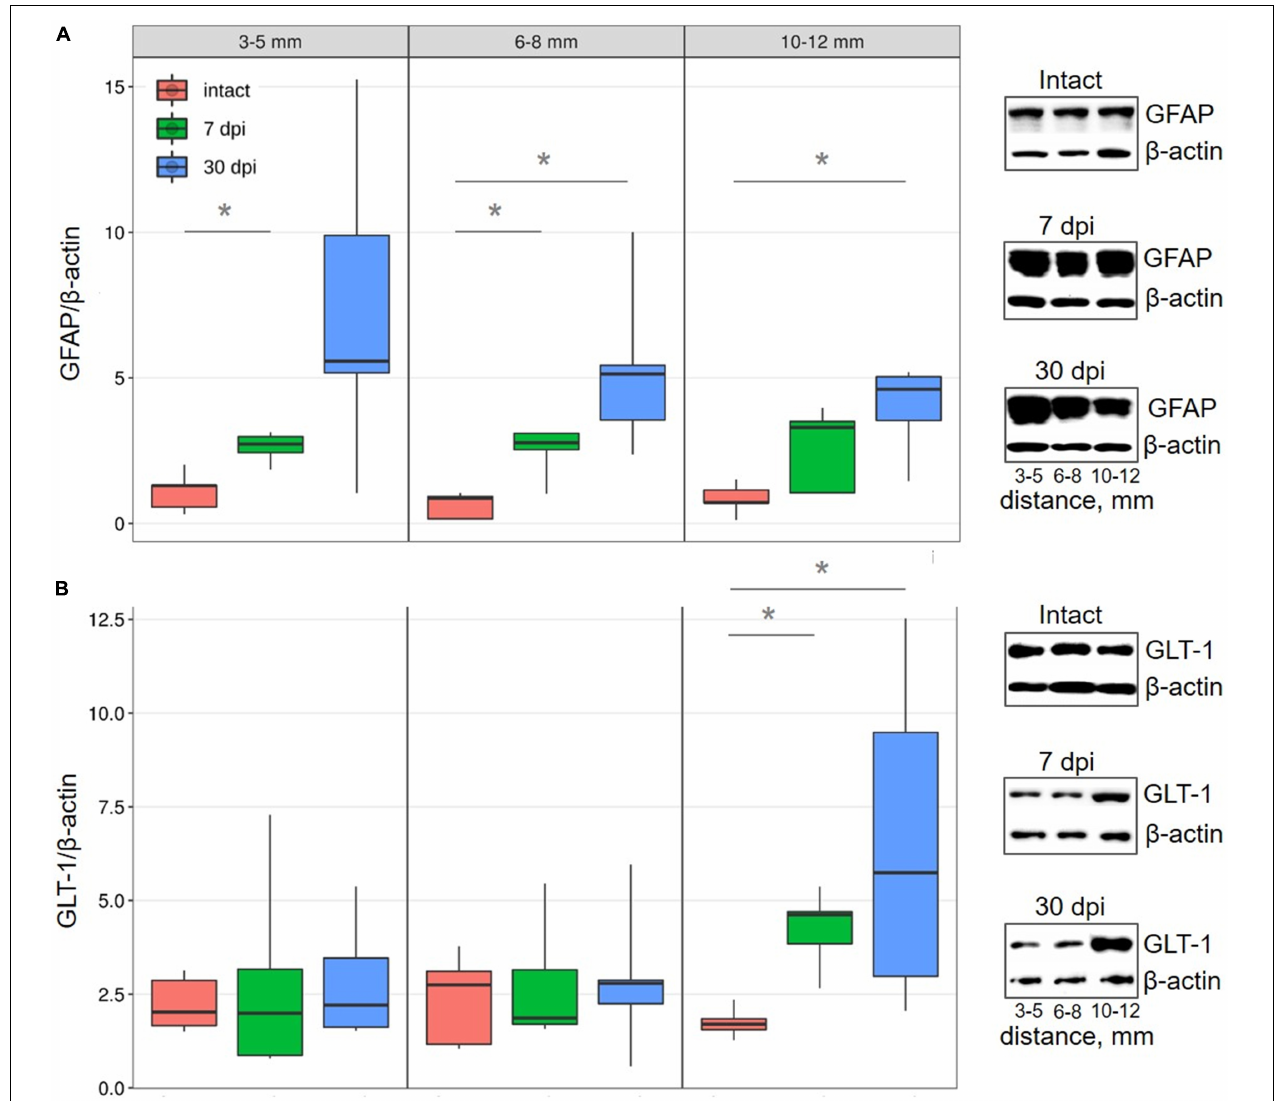
FIGURE 2 | Western blot analysis of astrocytes markers in the VH with increasing distance from the injury site in the caudal direction. Representative images of western blots showing GFAP (A) and GLT-1 (B) and their corresponding control – β -actin. Data are presented as the ratio of the number of target proteins to the reference protein ( β -actin), the average value ( n = 5 rats per group). * P < 0.05, Mann–Whitney